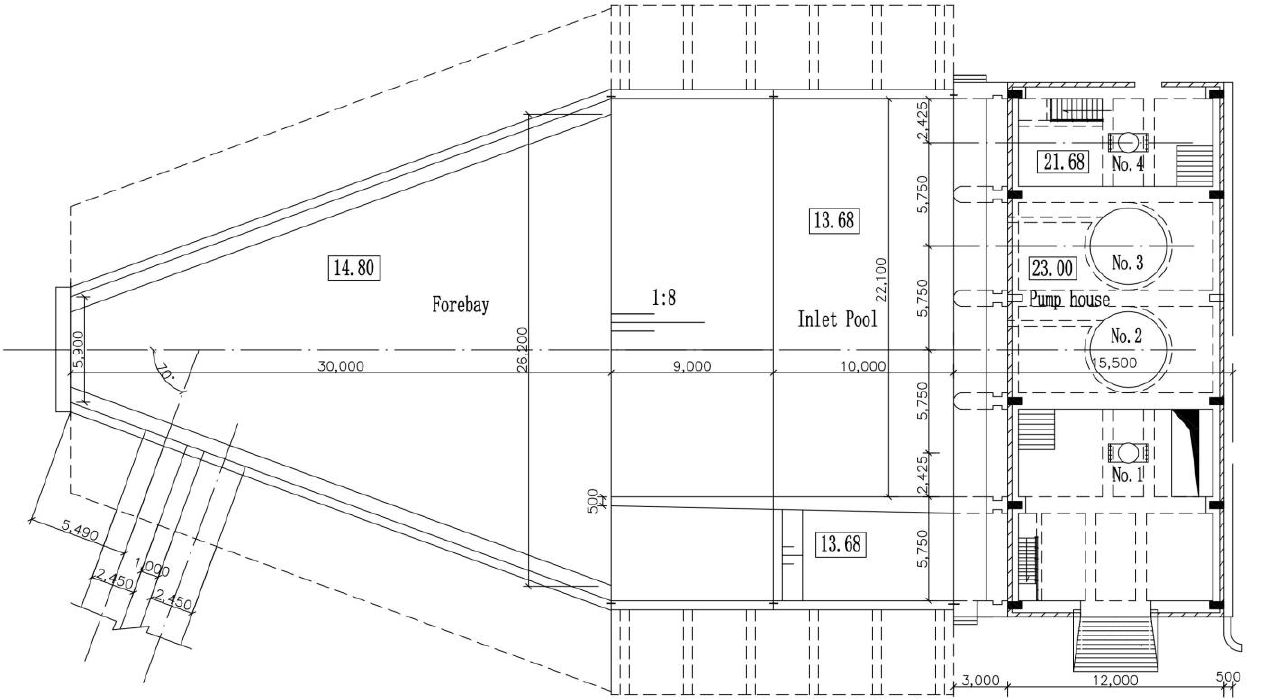
Figure 2. The plane layout of the certain lateral intake pumping station (EL: m, OTH: mm:). (Scale 1:200).